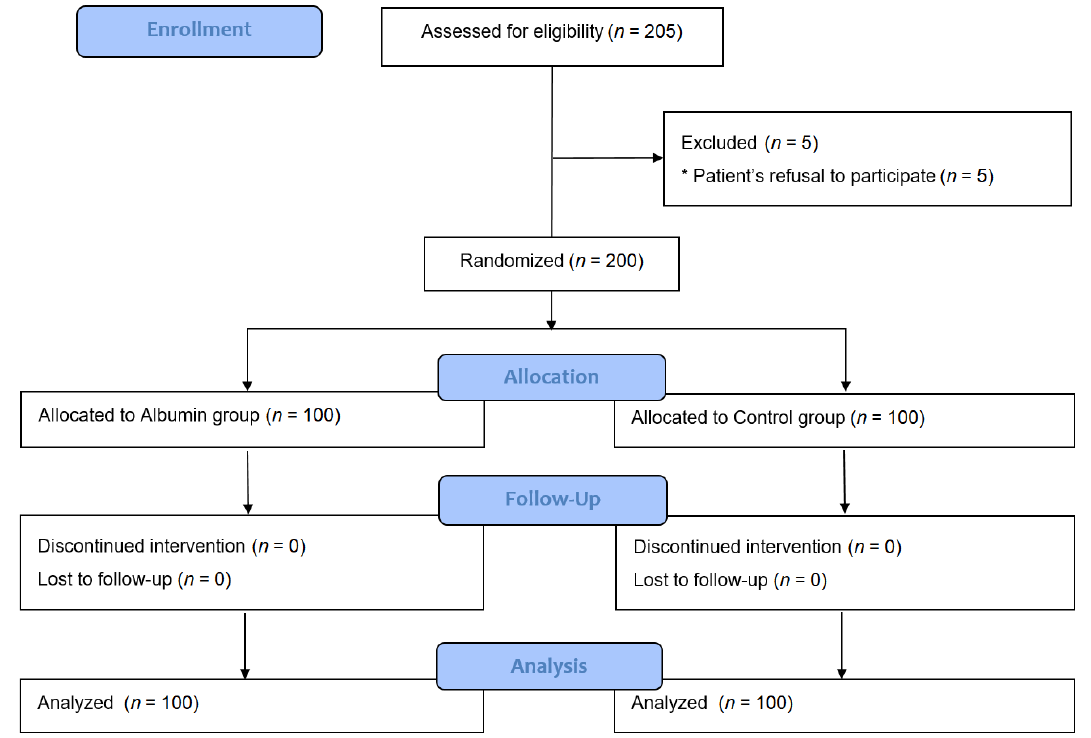
Figure 1. Consolidated standards of reporting trials flow diagram of the study.